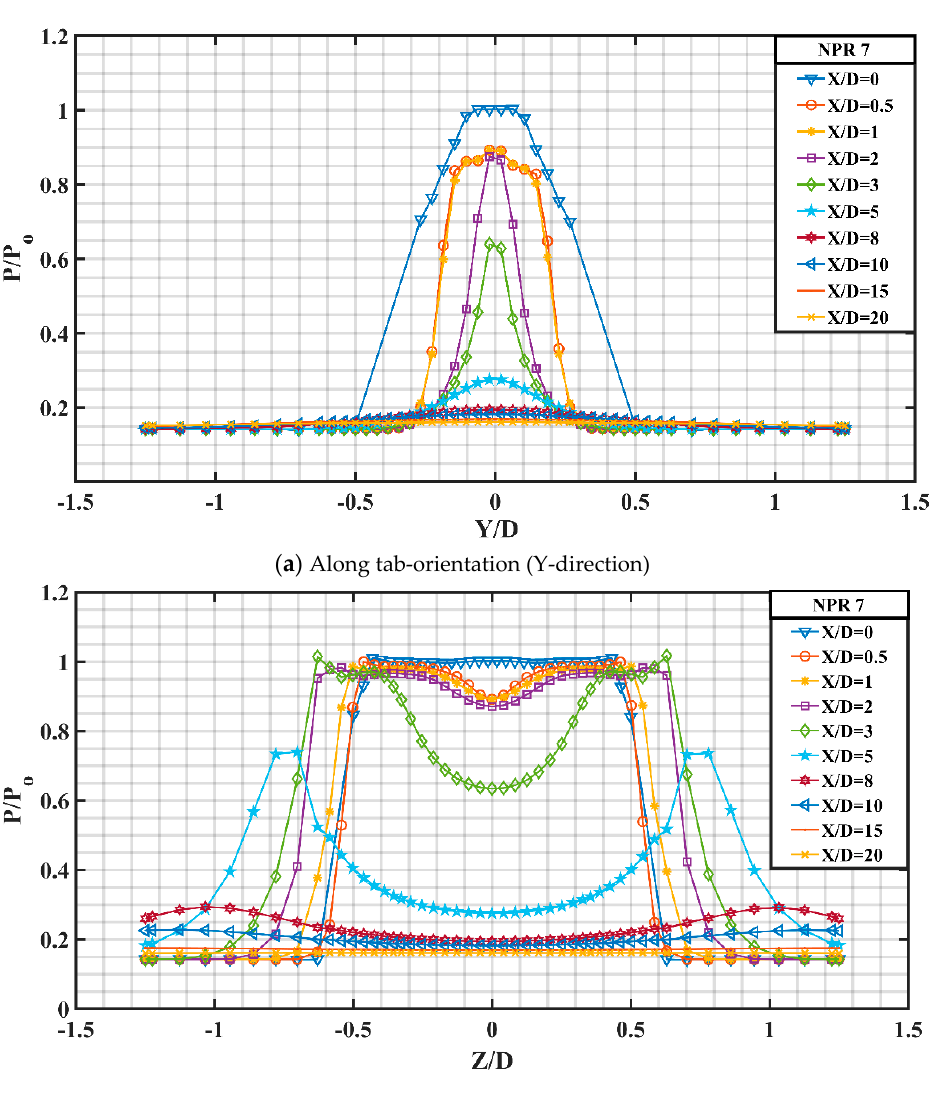
Figure 23. Pressure profile variation for controlled jet at NPR 7.